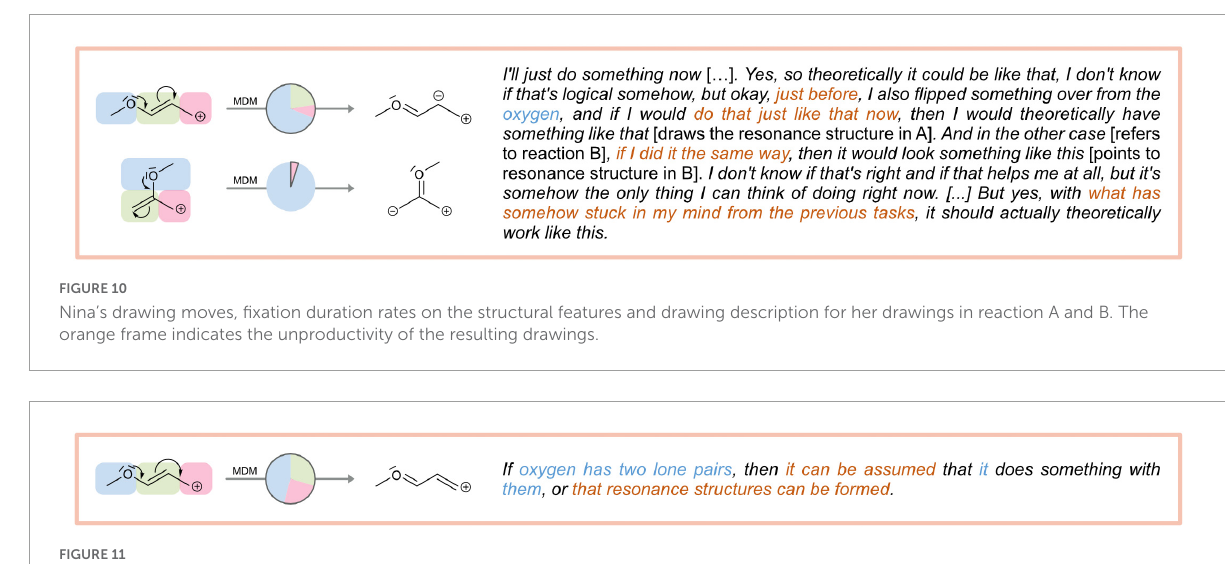
FIGURE11 Catherine’s drawing move, fixation duration rate on the structural features and drawing description for her drawing in reaction A. The orange frame indicates the unproductivity of the resulting